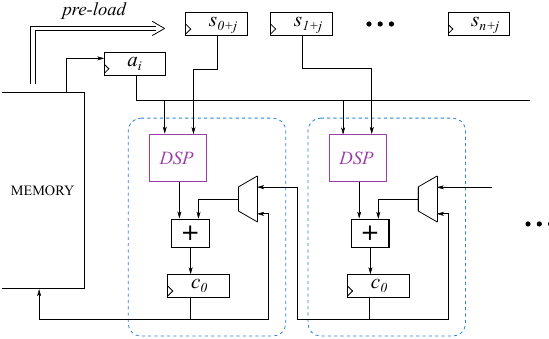
Figure 4: Architecture of the compact 64 × 64 polynomial multiplier used for